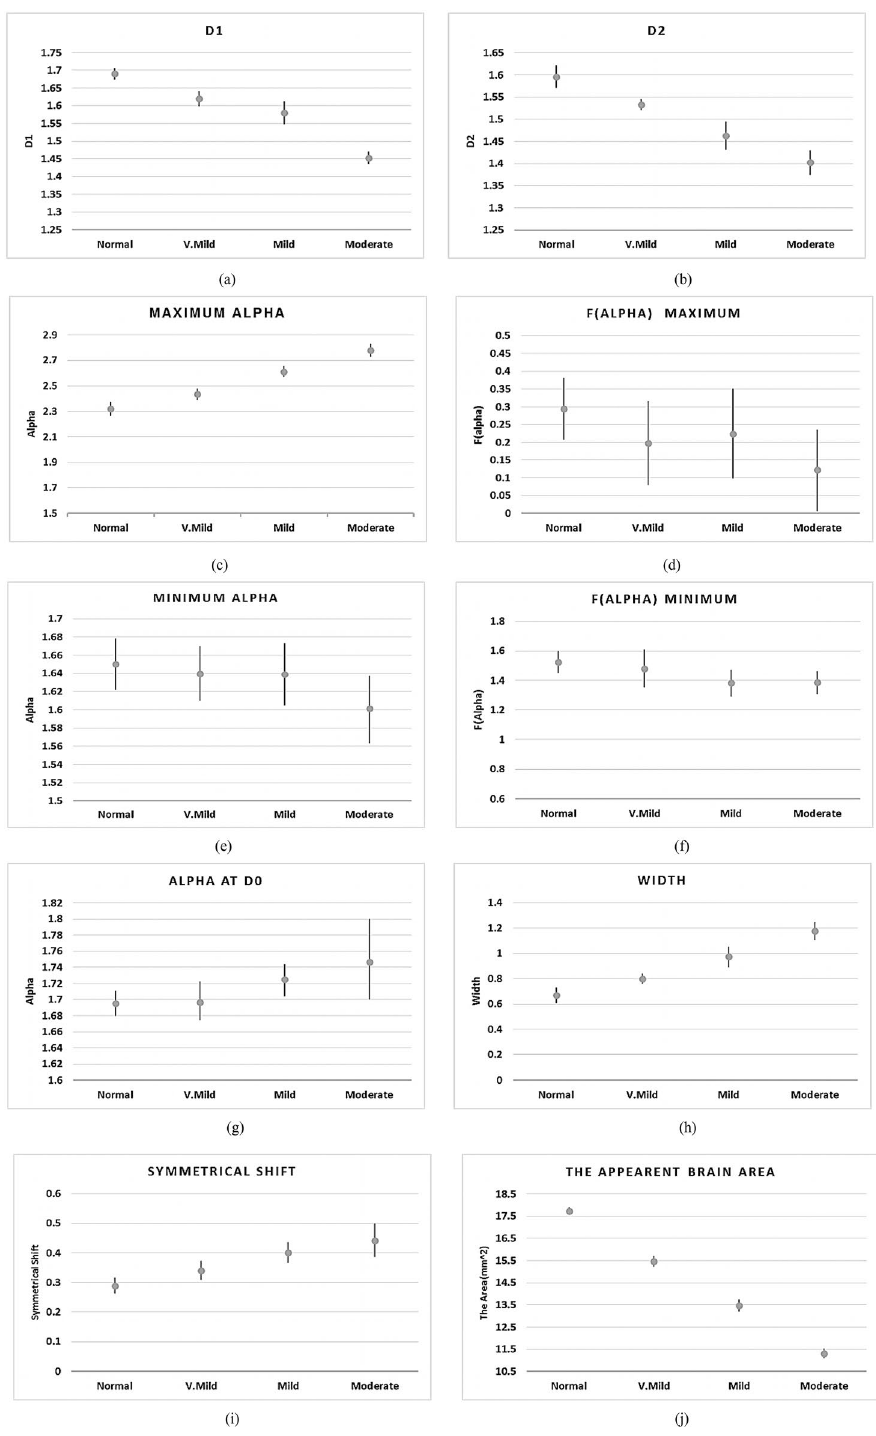
Figure 13. The statistical representation of the extracted features for the AD